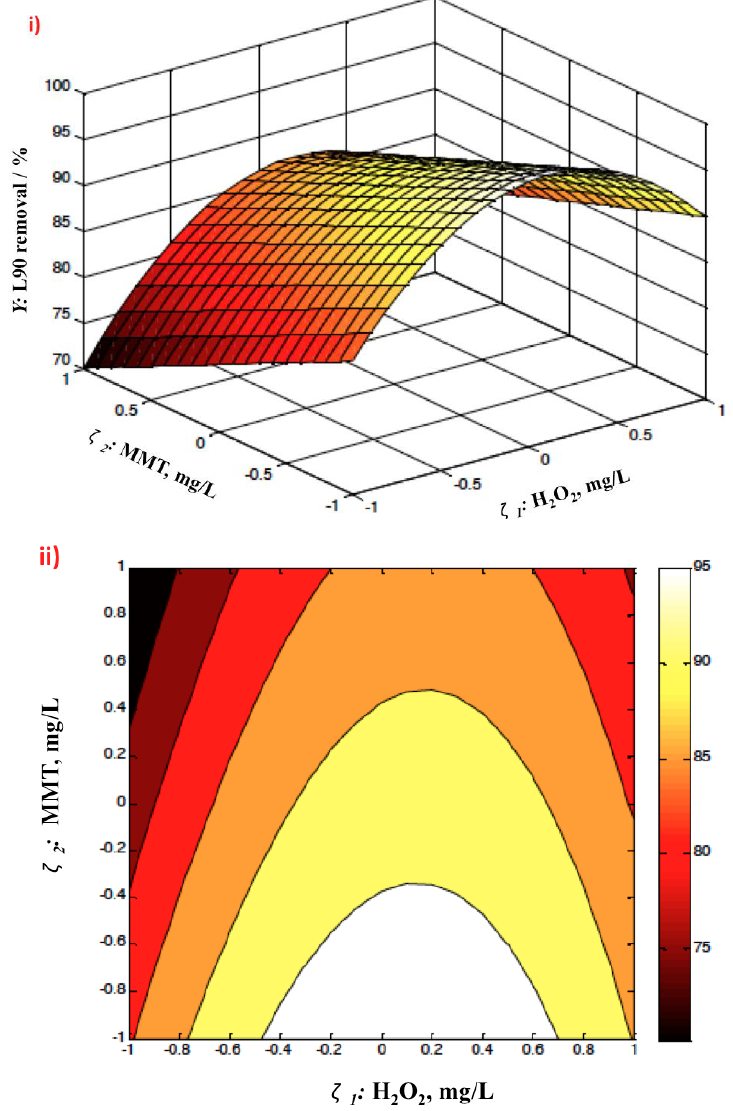
Figure 8. Factorial model design’s optimal results: ( i ) 3-D surface plot and ( ii ) 2-D contour plot of the ( Y ) response and the interacting effect of H 2 O 2 and Montmorillonite catalyst concentration.